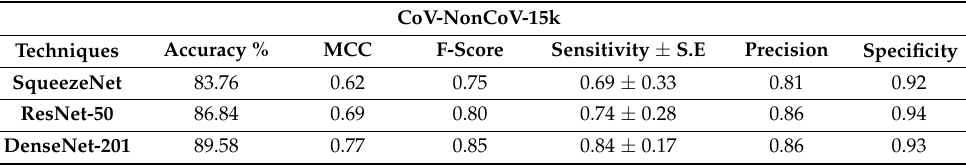
Table 5. Performance analysis of the reported CNNs on the test set of CoV-NonCoV-15k. S.E at 95% CI is reported for